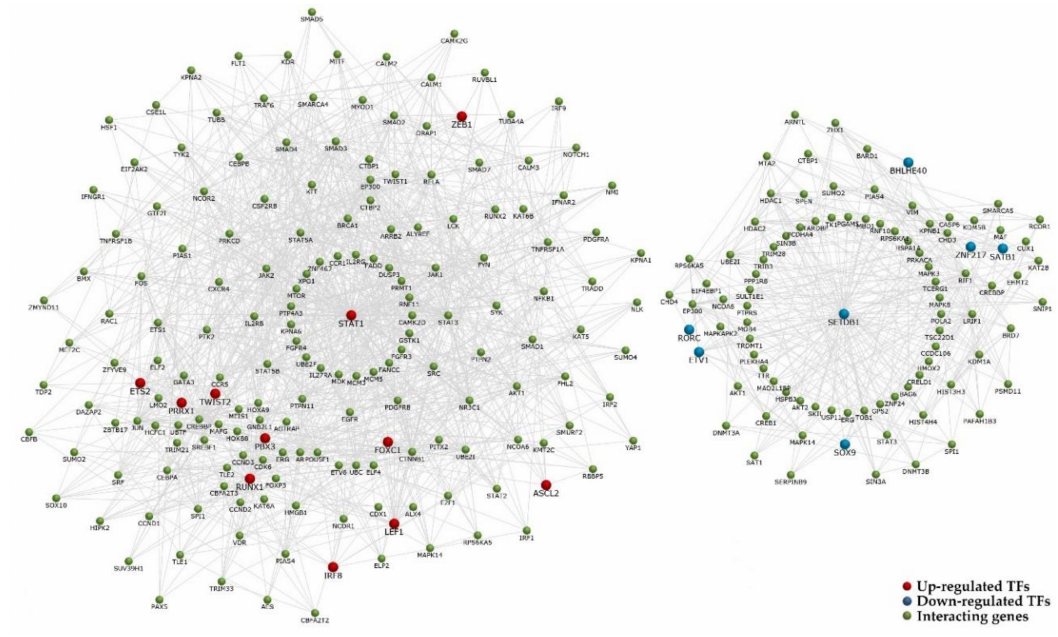
Figure 8. The interaction network of transcription factors di ff erentially expressed in M3. The 11 significantly up-regulated and seven down-regulated TFs in M3 tumors are highlighted by red or blue,